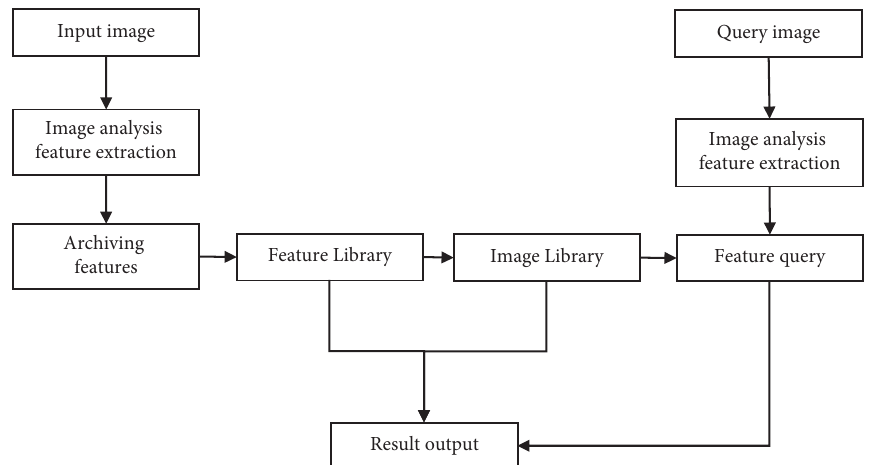
Figure 1: Flow chart of the image search based on the content.